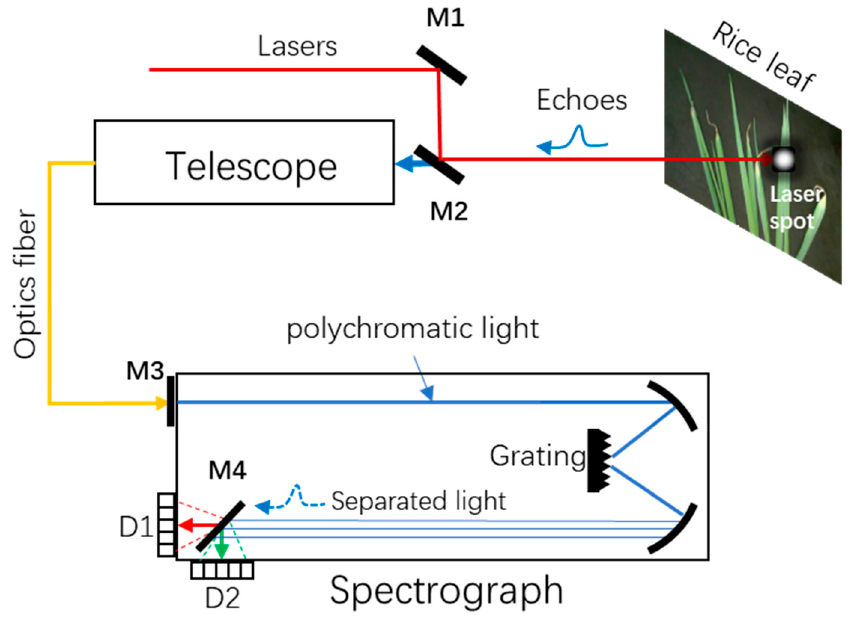
Figure 1. LiDAR systems used for reflectance and fluorescence spectra measurement.